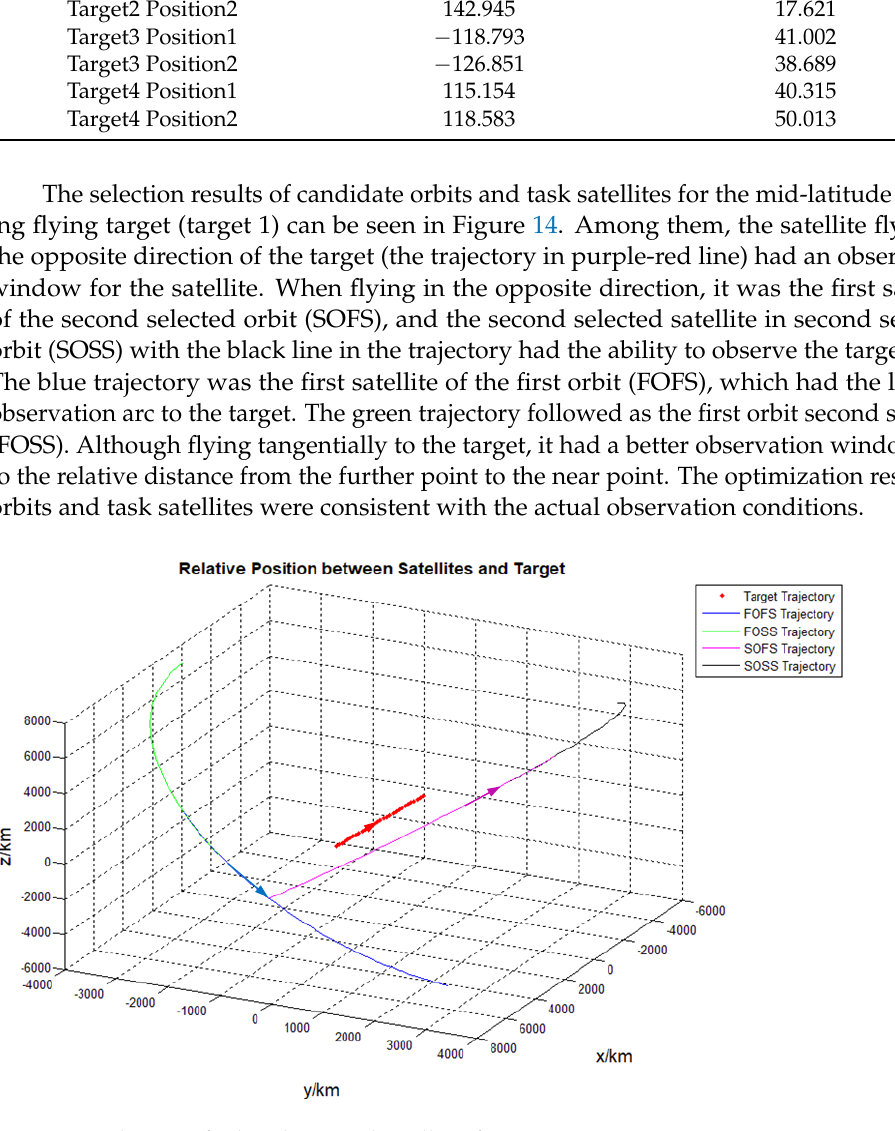
Figure 15. Selection of orbit planes and satellites for target2. Figure 16 shows the satellite selection results of the mid-latitude long-distance fly- ing target, the opposing flight orbit was selected as the first orbit, although there were fewer observing blind spots in the opposite direction. The four selected satellites were also the satellites with the best observation conditions under actual analysis.